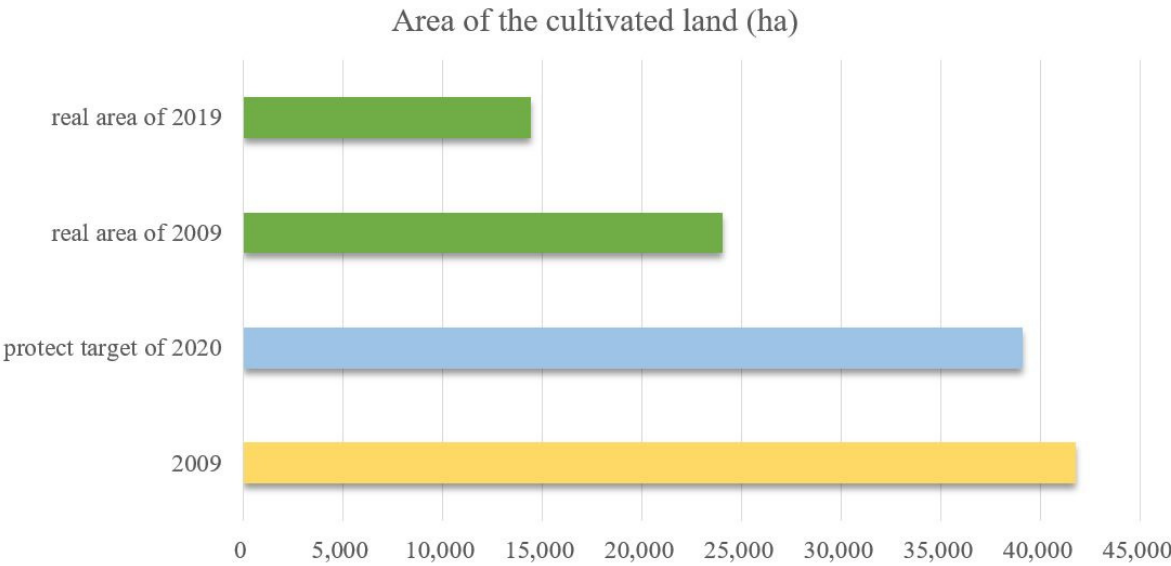
Figure 7. Changes of cultivated land area and original protection targets of cultivated land in Gaochun District.